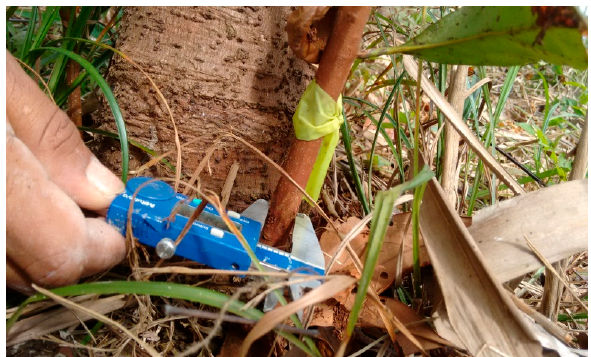
Figure A17. Measurement of shoot diameter after above ground cut at 50 cm using digital callipers in Central Amazonian commercial rosewood plantations.